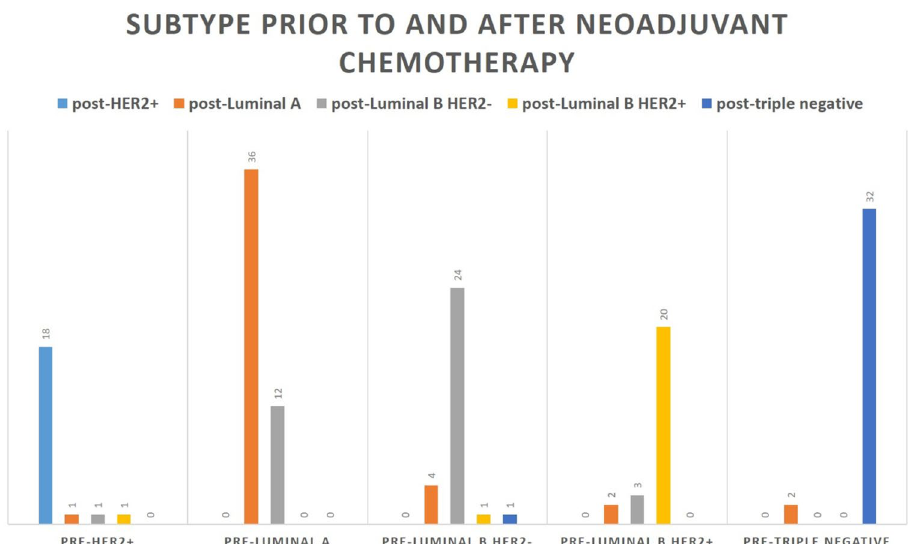
Figure 6. Biomarker changes after neoadjuvant chemotherapy in each intrinsic subtype.